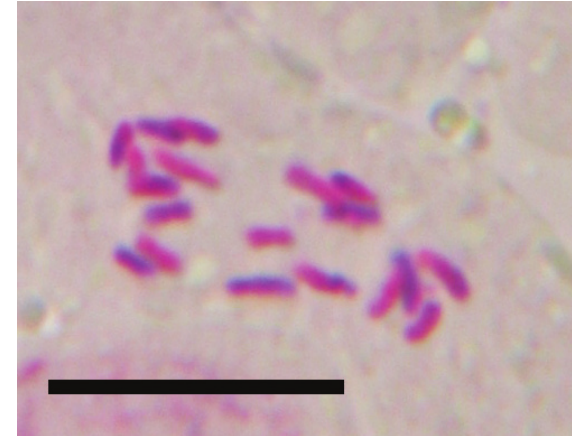
Figure 6. Centaurea scillae Brullo, 2 n = 18 + 2B. Scale bar: 10